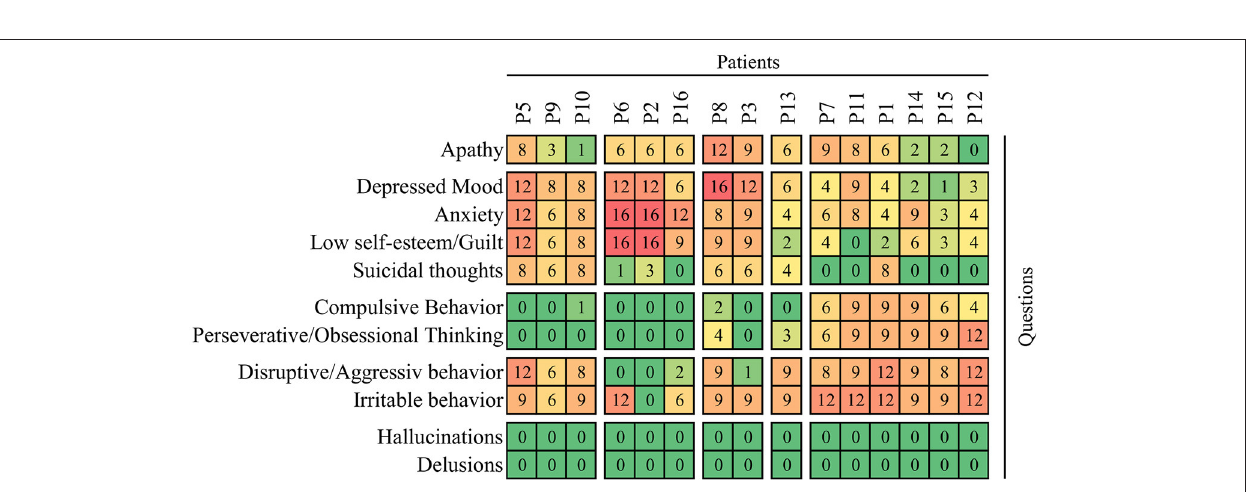
FIGURE 1 | Significant improvement in cognitive performance, which can only partly be explained by the effect on depression. Alteration of the cognitive performance and depression status of participants with HD after starting administration of cariprazine. (A) Line plot shows the difference in individual points scored by Beck’s Depression Inventory (0–63) compared to the baseline and 8 and 12th weeks, respectively. Next to the diagram, all of the participating patients are listed in the order of the largest difference in observed change over the observation period. The baseline points in brackets, followed by change at the 12th week is shown. (B) Line plot for Addenbrook’s Cognitive Examination (ACE) questionnaire (0–100). On both diagrams, the color intensity of the lines is proportional with the severity on the depression scale in a similar way.